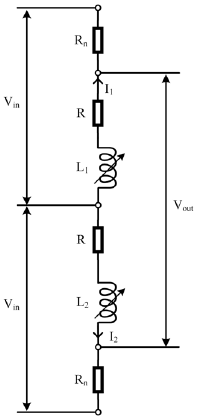
Figure 10. DCPD excitation method.